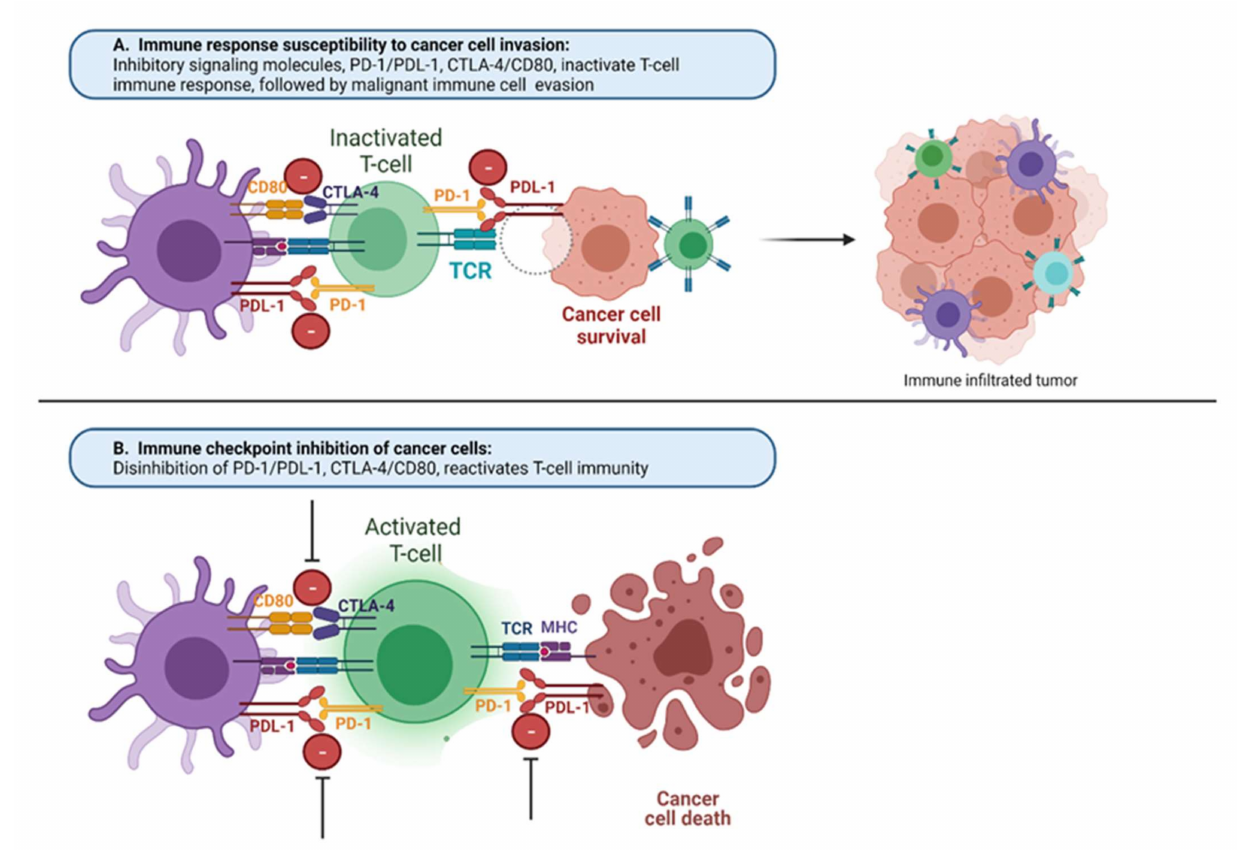
Figure 1. Mechanisms of the immune response under malignancy and with immune checkpoint inhibitors: ( A ) immune response susceptibility to cancer cell invasion. Common ligands, MHC and PDL-1, found on immune macrophages (purple) and cancer cells (brown) compete with binding to receptors on T cells (green) TCR and PD-1, which normally regulate the immune response. When im- munologic homeostasis is compromised between positive (TCR/MHC) and negative (CTLA-4/CD80, PD-1/PDL-1) signaling of T-cell activation, cancer cells can avoid the immune response of the host and escape from immune cell attack, providing cancer cell growth and proliferation uncontrollably; ( B ) in presence of immune checkpoint inhibitors toward CTLA-4/CD80, PD-1/PDL-1 signaling, there is disinhibition of these pathways and reactivation of T cells toward cancer cell death. MHC, major histocompatibility complex; PD-1, programmed cell death protein 1; PD-L1,